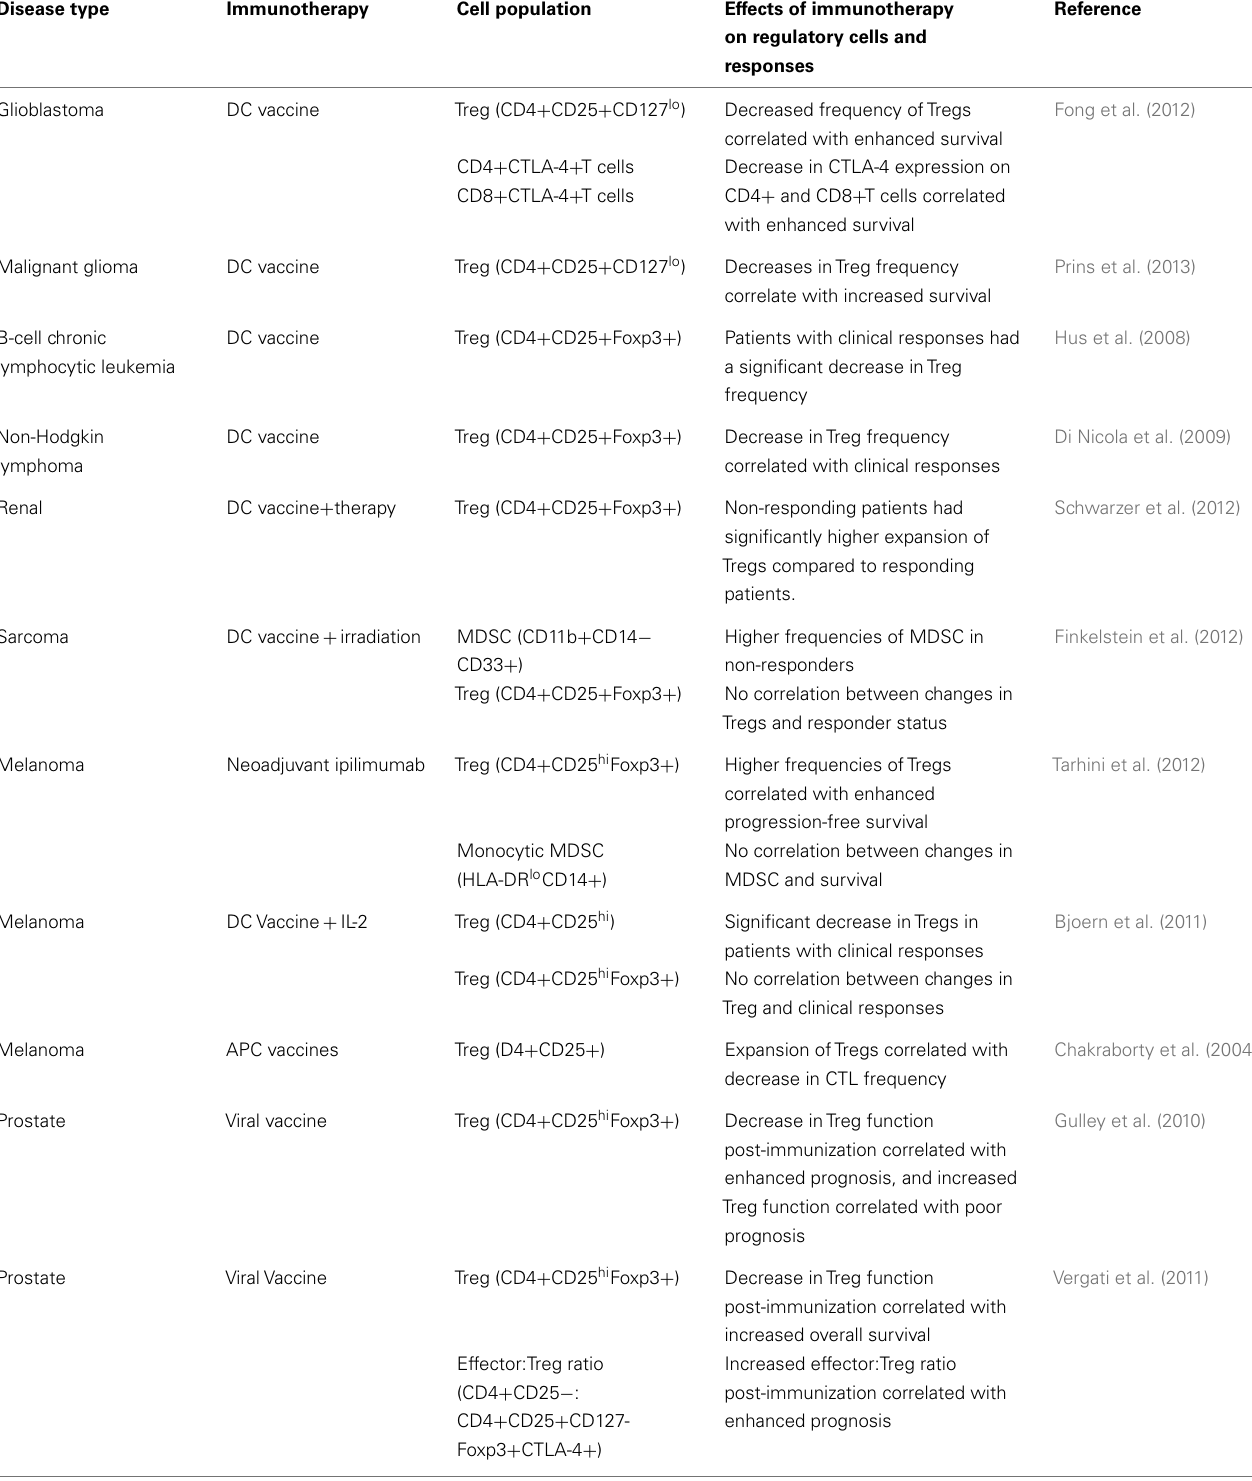
Table 1 | Clinical trials evaluating the effect of immunotherapy on regulatory cell frequency, and correlations with immune and clinical